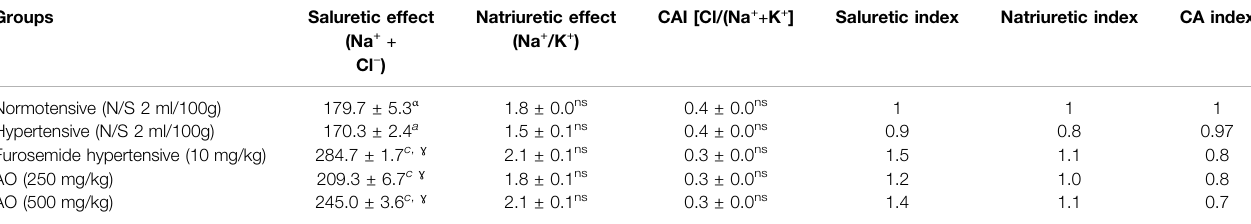
TABLE 9 | Effect of administration of Alpinia of fi cinarum on saluretic effect, natriuretic effect, and carbonic anhydrase inhibition of chronic obesogenic diet-fed hypertensive rats at 24 h on the last day of the model.